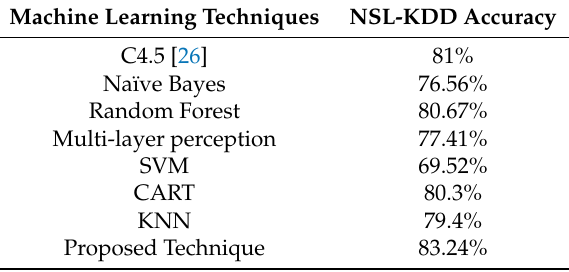
Table 18. Performance comparison between di ff erent classifiers and proposed algorithm on KDDTest +